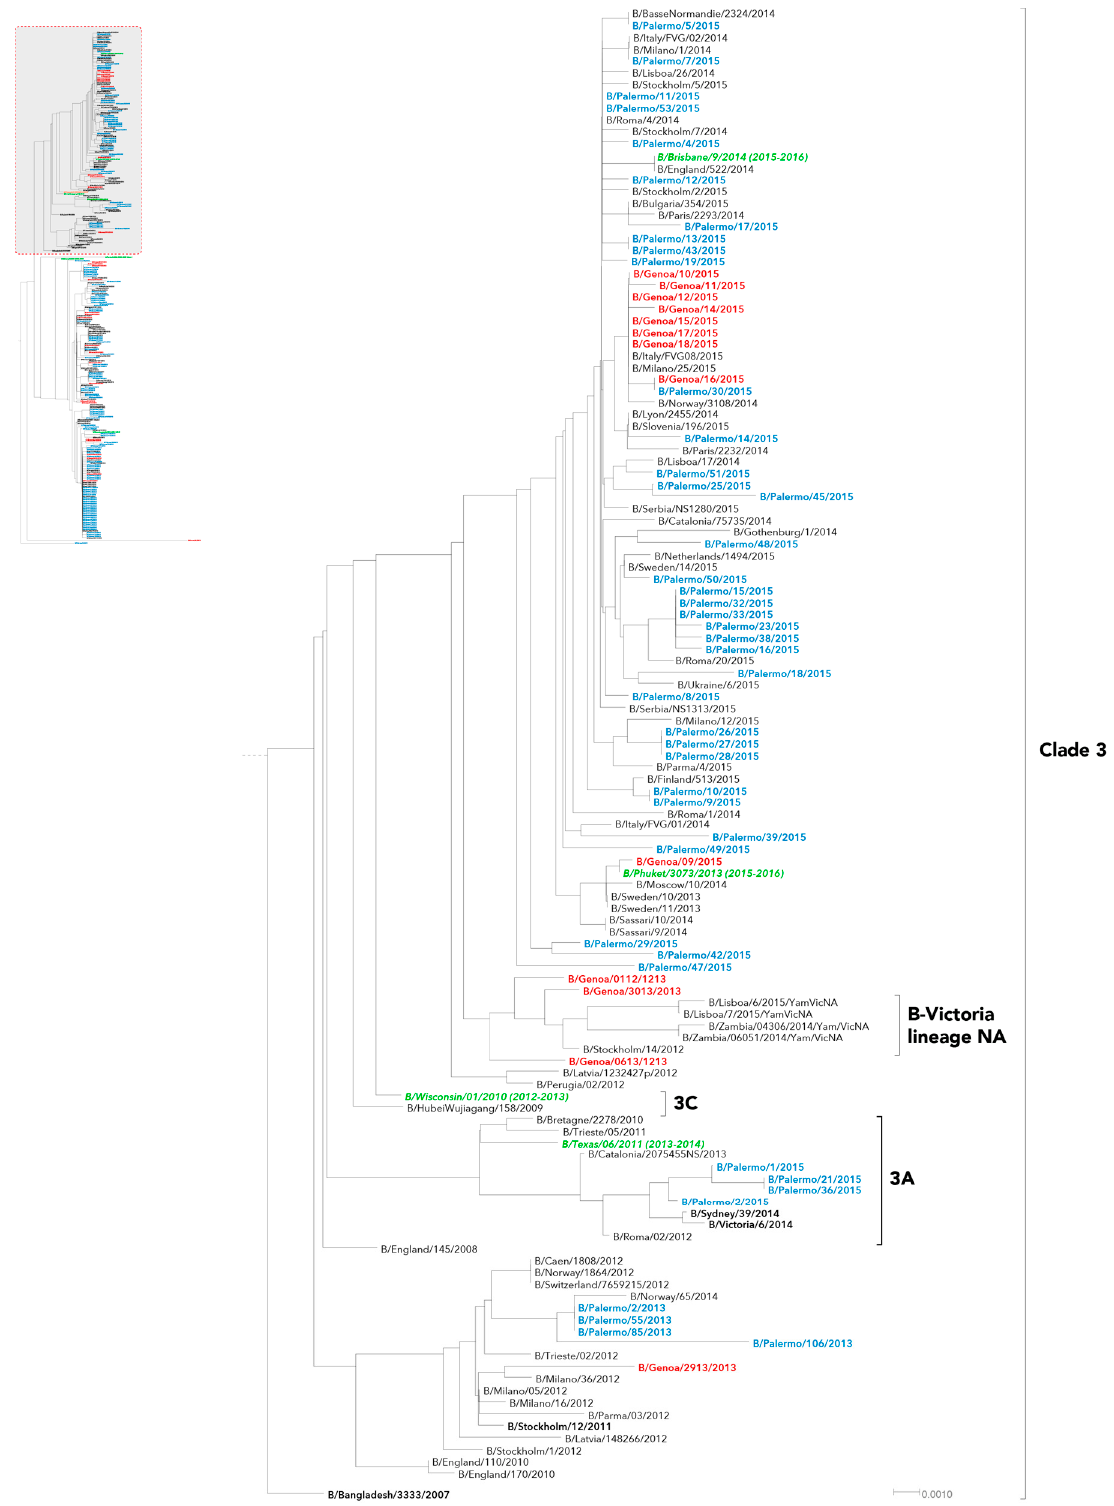
Figure 3. Phylogenetic analysis of the HA nucleotide sequences from influenza B Yamagata-lineage clade 3 viruses isolated in Italy from 2010 to 2015. The phylogeny tree was generated by the neighbor-joining method with 1000 bootstrap replicates. Sicilian strains (blue color), Ligurian strains (red color), WHO recommended candidate vaccine (green color) and reference strains (black color, bold font).